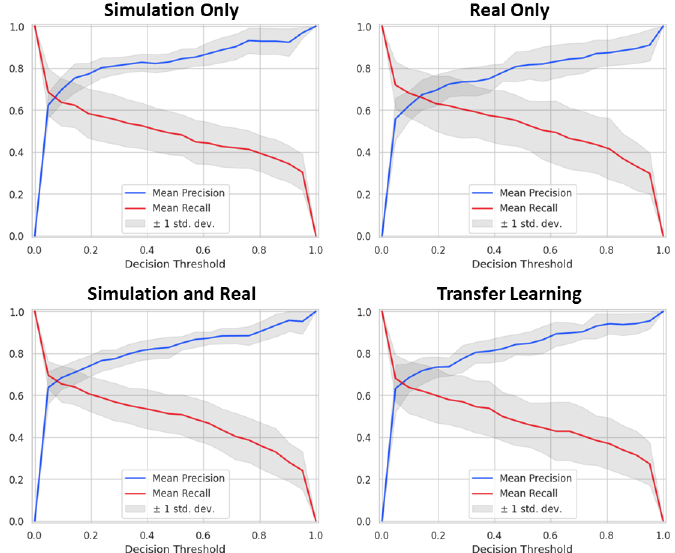
Figure 6. Precision and recall plotted over decision threshold. Solid lines represent the mean performance of the five K-fold networks, while the gray areas around them show the standard deviation. The chosen decision threshold for every network fell between 0.05 and 0.1.